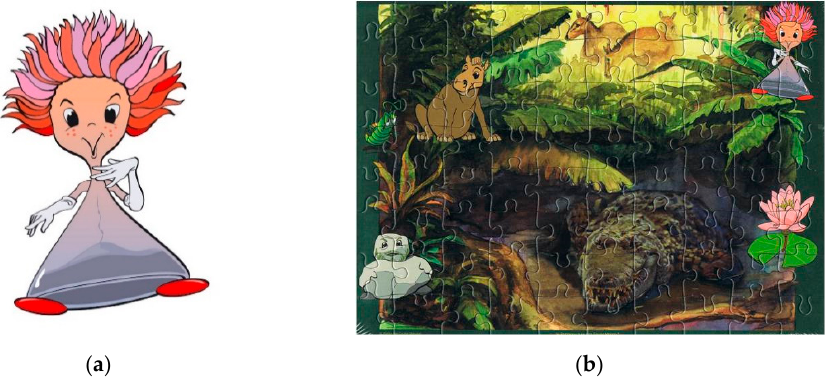
Figure 19. ( a ) Fiora Eocene—Queen of Time of the Time Travel Crew Messel Pit WHS. ( b ) Jigsaw puzzle of the time travel crew.